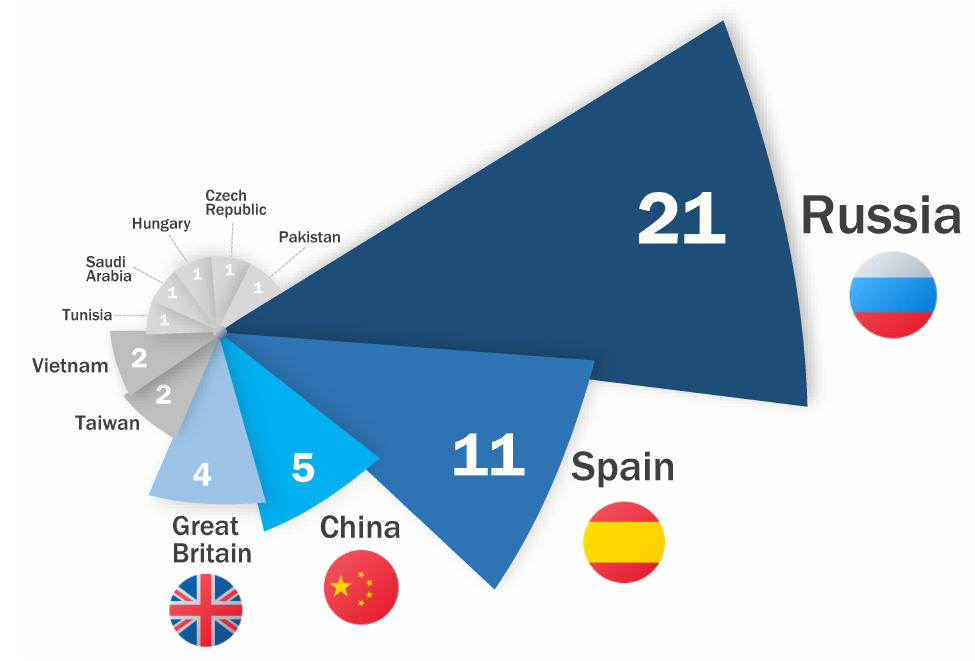
Figure 1. Authors and corresponding